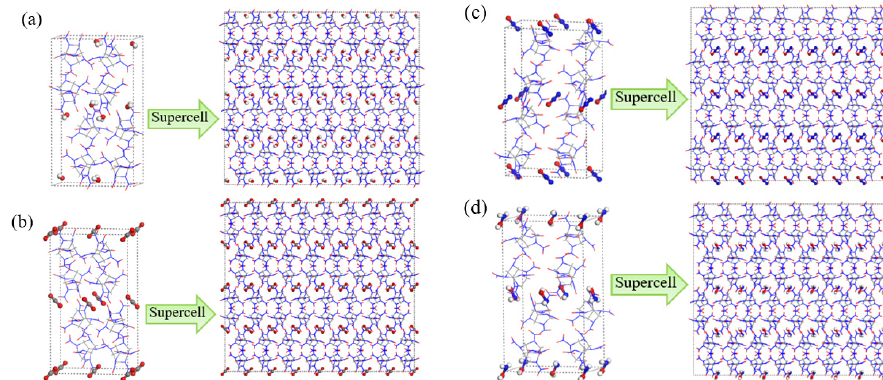
Figure 16. ( a ) α -CL-20/H 2 O, 6 × 4 × 2 α -CL-20/H 2 O supercell, ( b ) α -CL-20/CO 2 , 6 × 4 × 2 α -CL-20/CO 2 supercell, ( c ) α -CL-20/N 2 O, 6 × 4 × 2 α -CL-20/N 2 O supercell, ( d ) α -CL-20/NH 2 OH, 6 × 4 × 2 α -CL-20/NH 2 OH supercell. The blue atoms represent nitrogen, the red atoms represent oxygen, the white atoms represent hydrogen, the gray atoms represent carbon. The supercell of ( a ) contains 384 of CL-20 and 384 of guest. The supercell of ( b – d ) contains 384 of CL-20 and 192 of guest.